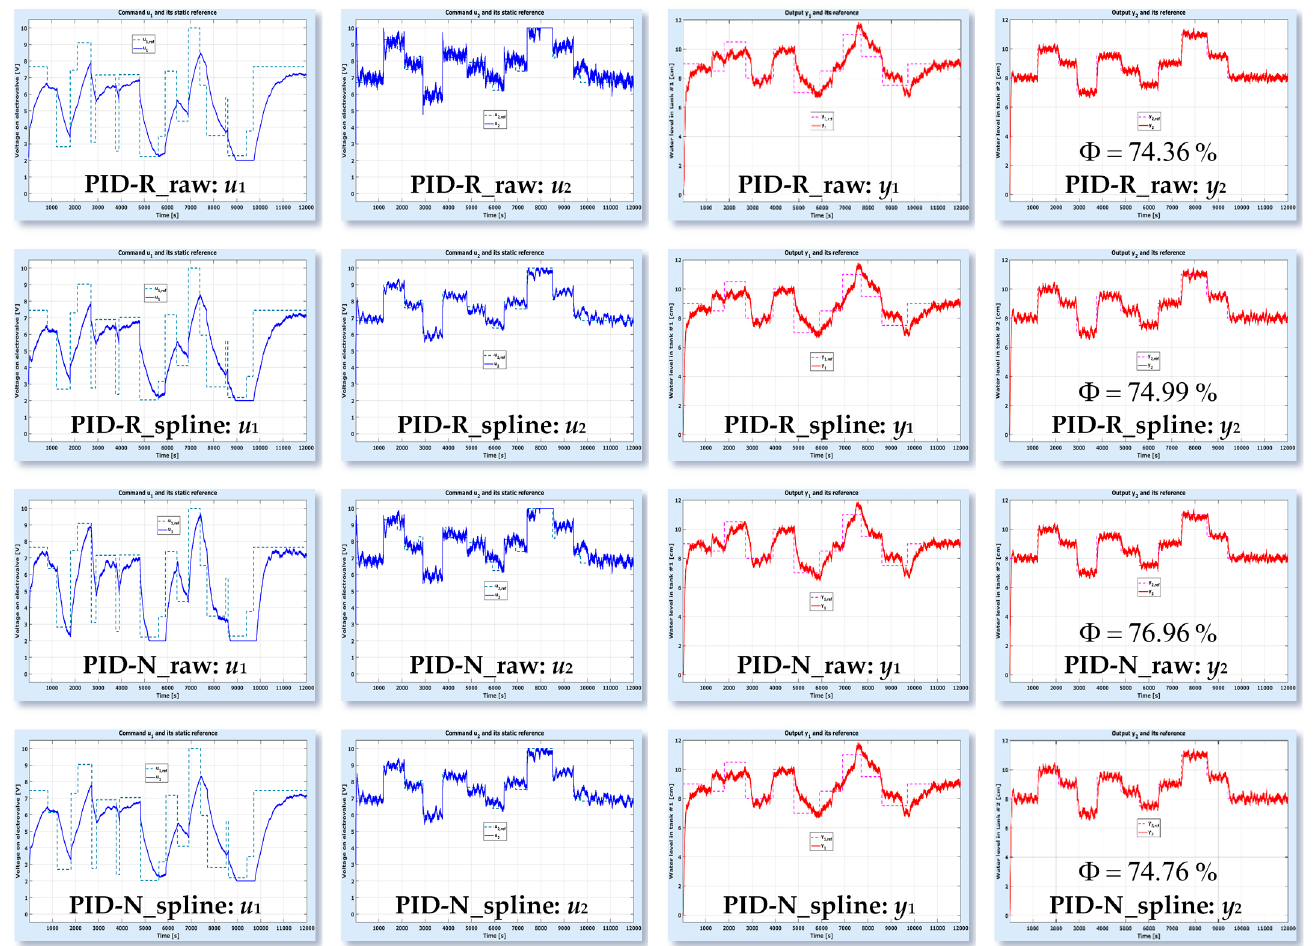
Figure 21. PID-ASTANK2 performance for switched references of the previous figure.